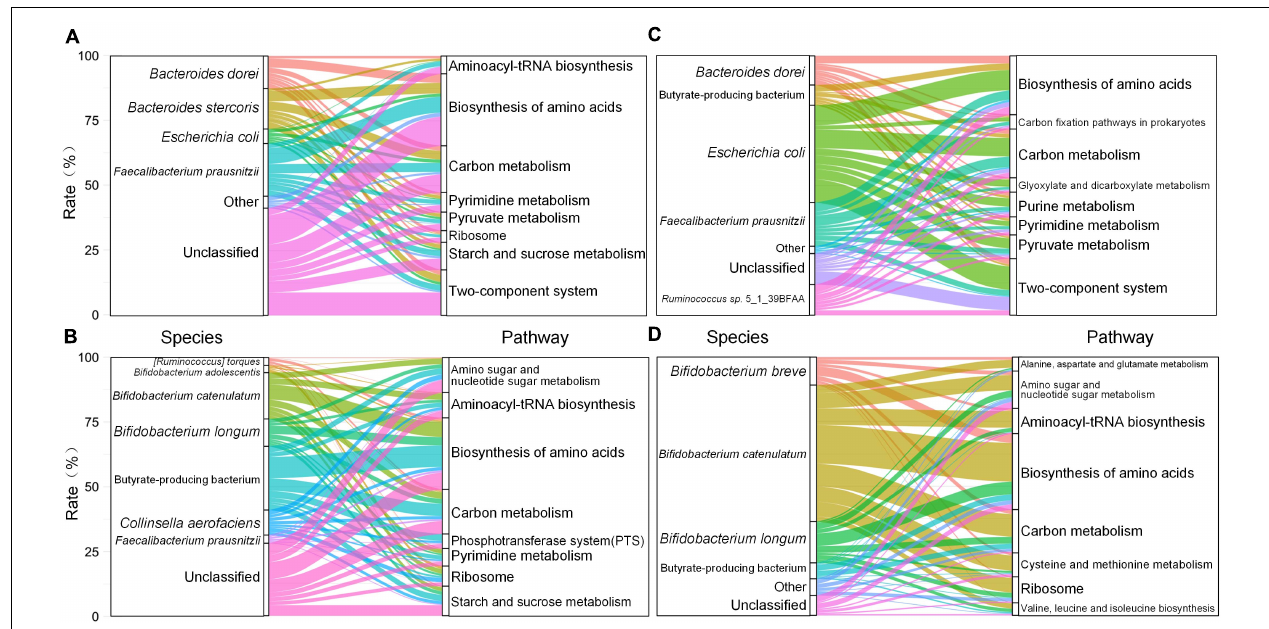
FIGURE 2 | Species and metabolic pathways corresponding to the genes with differential SNP density between before and after intervention in obese children. (A) The corresponding species and metabolic pathways of the genes with high SNP density in PWS before the intervention. (B) The corresponding species and metabolic pathways of the genes with high SNP density in PWS after the intervention. (C) The corresponding species and metabolic pathways of the genes with high SNP density in SO before the intervention. (D) The corresponding species and metabolic pathways of the genes with high SNP density in SO after the intervention.